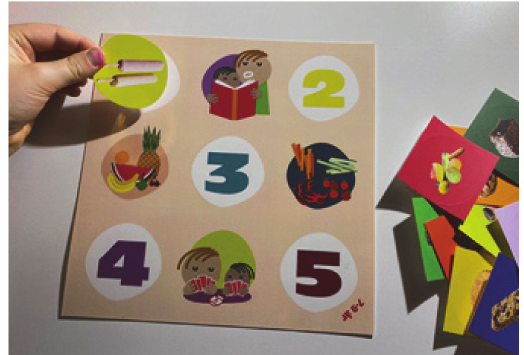
Figure 7. Serving size board. Here are illustrated five servings, but the stickers can easily be removed and replaced with others the week